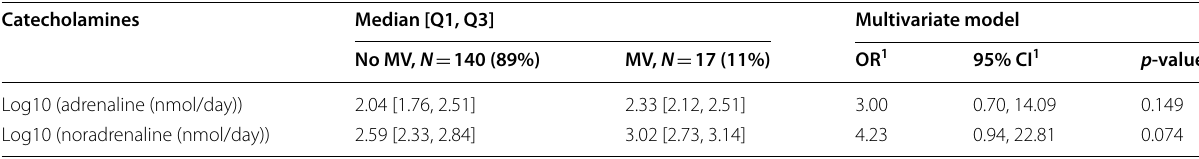
Table 3 24-h urinary catecholamine excretion on the 5th day of treatment and mechanical ventilation required (MV) required after exclusion of patients required MV before day 5 (n